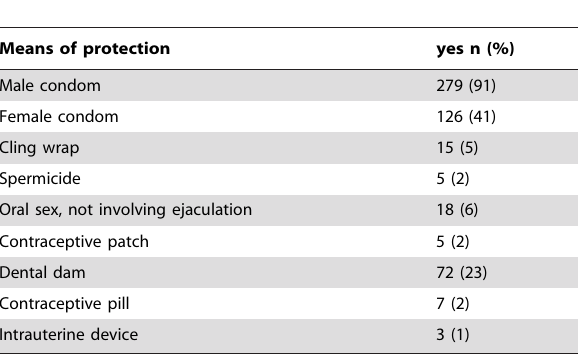
Table 3. Proportion of positive responses to nominated measures against STI when engaging in oral sex.